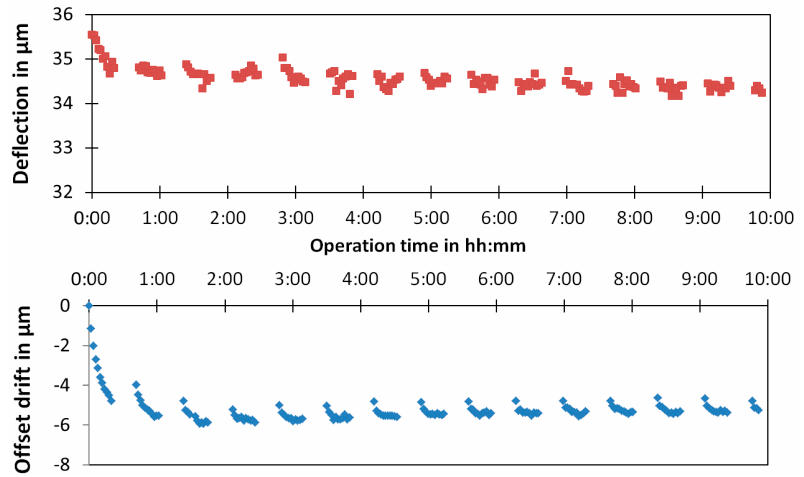
Figure 8. Dynamic characteristic for long-term operation at 100 mW and a maximum temperature of 80 °C: Electrical input power, amplitude and offset drift versus actuation